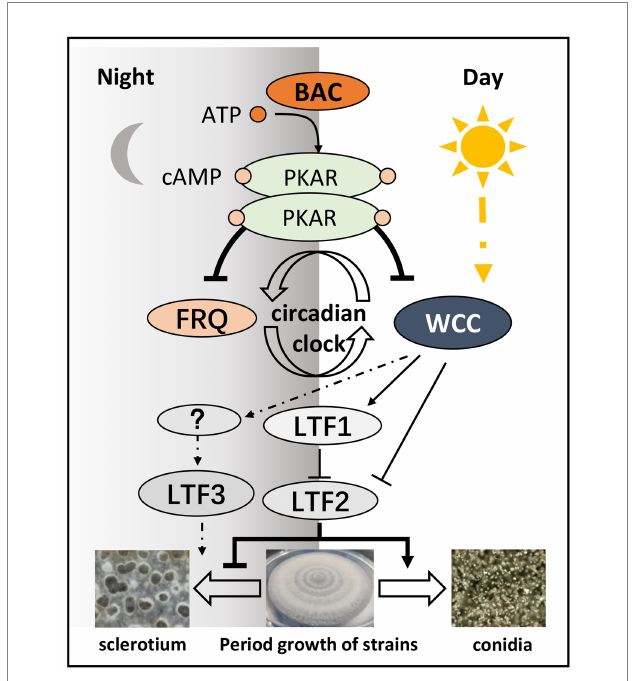
FIGURE 11 The conidiation and sclerotia formation in B. cinerea are regulated by the cAMP signaling